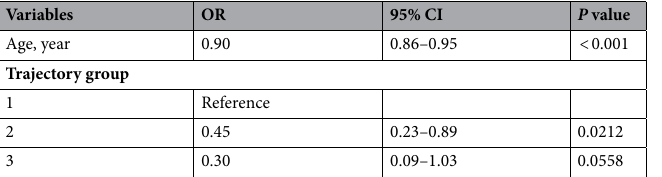
Table 4. Multivariate analysis of predictors for CPSP at 3 months. CPSP Chronic postsurgical pain. Adjusted for gender, age, BMI, occupation status, education level, marital status, smoking, alcohol drinking, hypertension, diabetes, coronary heart disease, ASA physical status, preoperative chronic pain, previous surgery, site of surgery, type of surgery, duration of surgery, MME consumption, number of drainage tube, tube retention time ,length of hospital stay, malignant tumor, preoperative anxiety, preoperative depression, expected postsurgical pain intensity, SFQ-s, SFQ-l, and trajectory model.